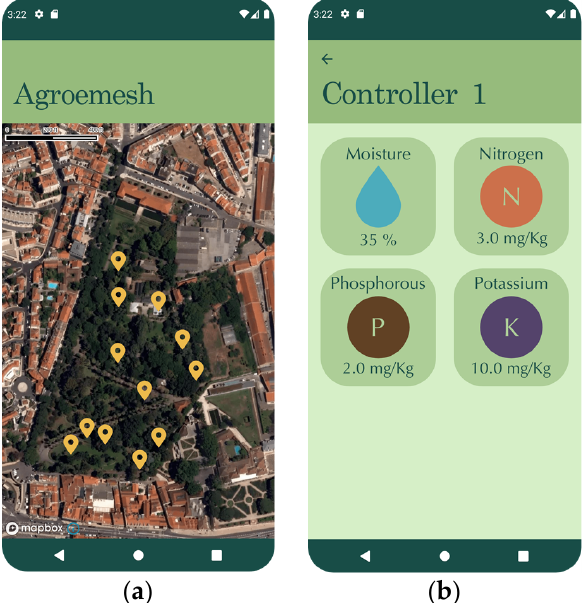
Figure 8. Agroemesh and Controller screens : ( a ) Agroemesh Map screen; ( b ) Soil status screen for selected controller localization.